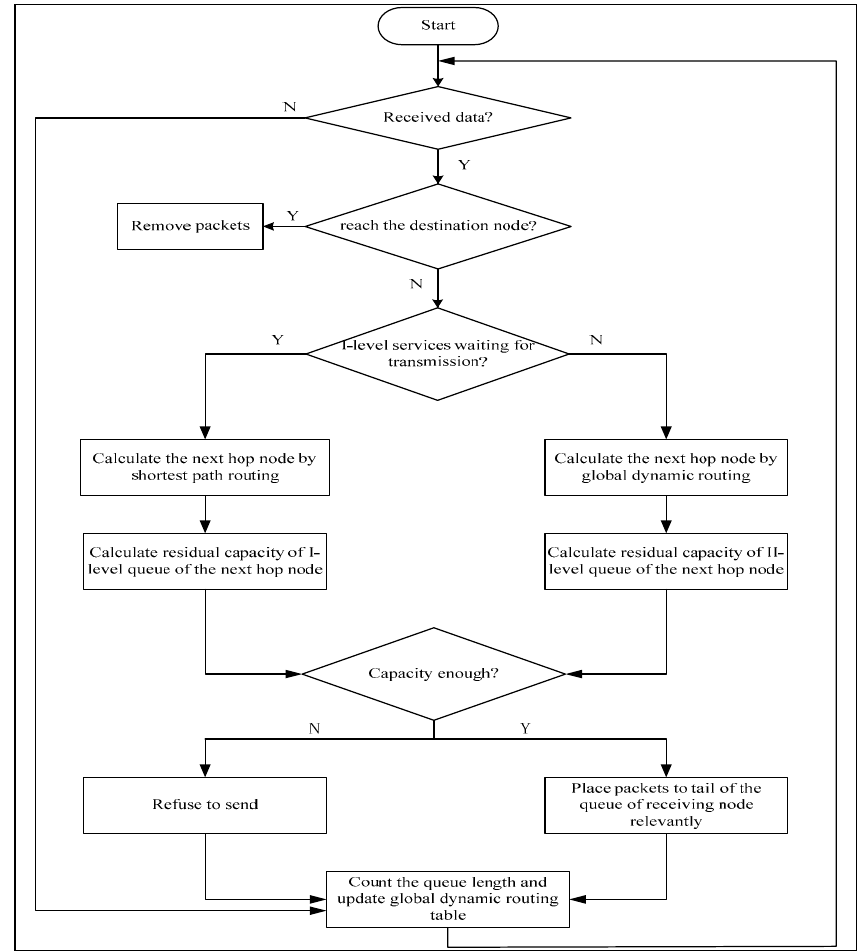
Figure 6. The flowchart of integrated routing.